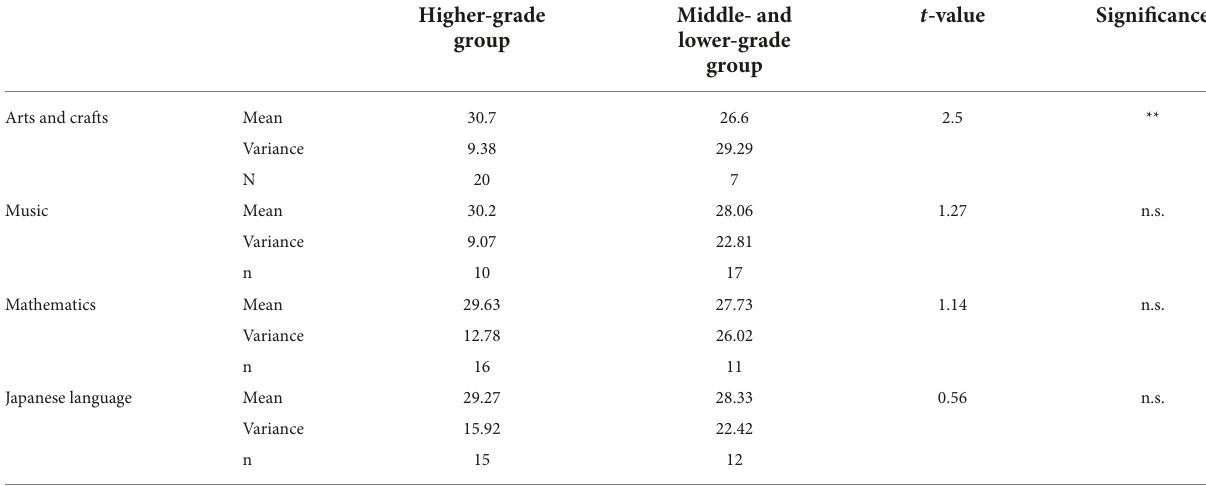
TABLE 1 Second-grade students’ skills in arts and crafts and other subjects and performance in the repeated side jump task (September–December 2011).